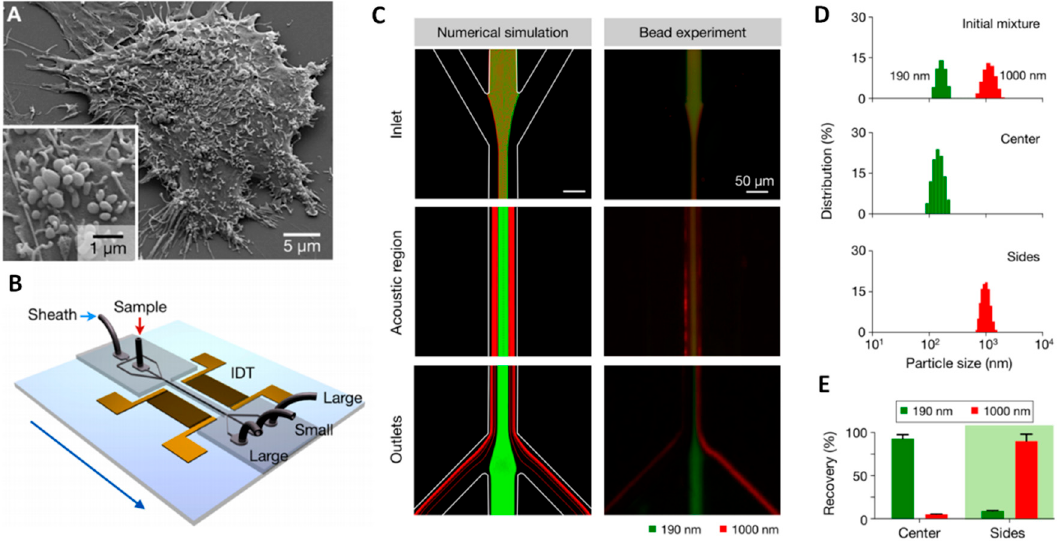
Figure 8. ( A ) MVs released by a human brain tumor cell; ( B ) Scheme of the acoustic nanofilter device